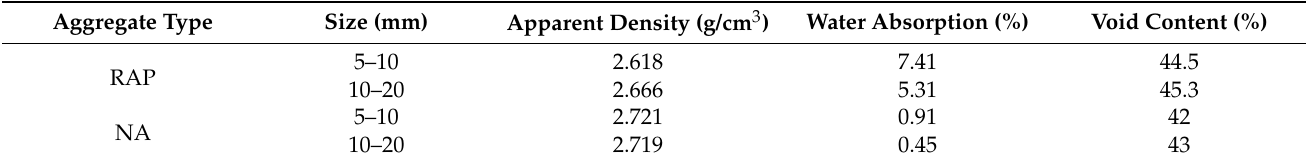
Table 1. Physical properties of aggregates.